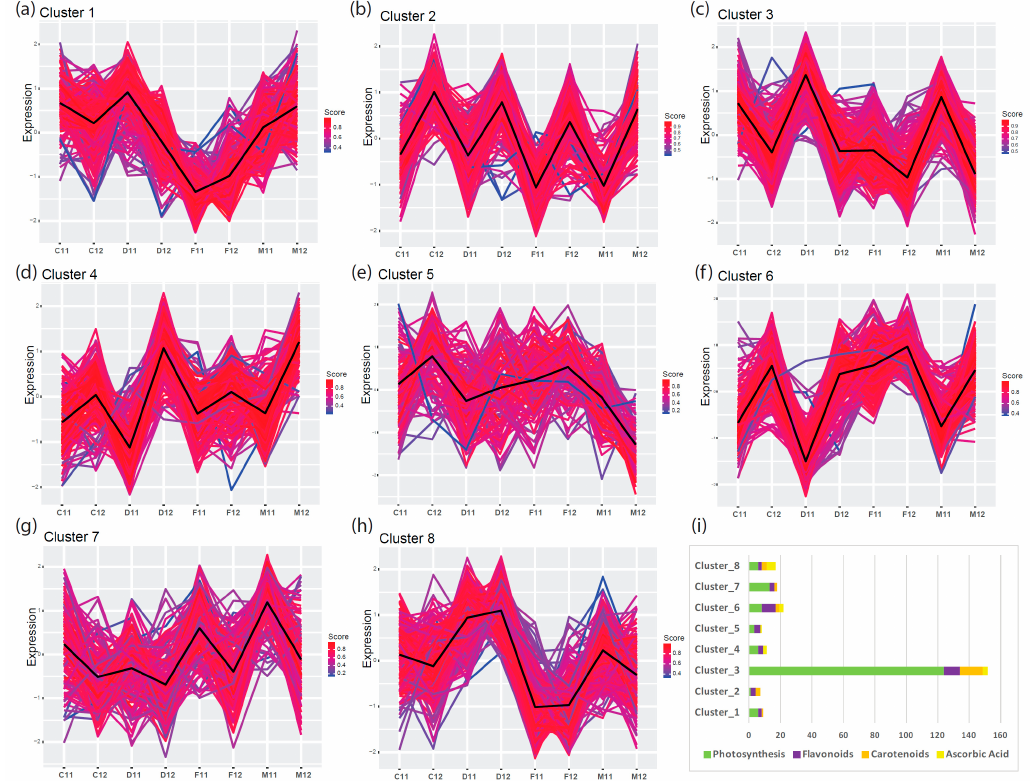
Figure 2. K ‐ means cluster analysis of TF ‐ PHOTO gene expression in the leaves of field ‐ grown endives and escaroles for two production cycles (from 2011 to 2012). Distance matrix for k ‐ mean clustering was calculated by Euclidean similarity measurement and using centered Pearson’s correlation as the distance metric, resulting in eight gene clusters ( a – h ). Genes with a profile close to the core have a score approaching one (red) while those with divergent patterns have a score closer to zero (blue). Thick lines show centroid tendencies in each cluster according to cultivar and production year. C, Confiance; D, Domari; F, Flester; and M, Myrna. Cluster three ( c ) contains most of the genes directly related to photosynthesis and is highly anticorrelated with cluster six ( f ) (r = − 0.97) which likely contains negative regulators of photosynthesis or antagonistic pathways. ( i ) Graphical visualization of enrichment results and gene characteristics according to gene ontology (GO) functional categories.